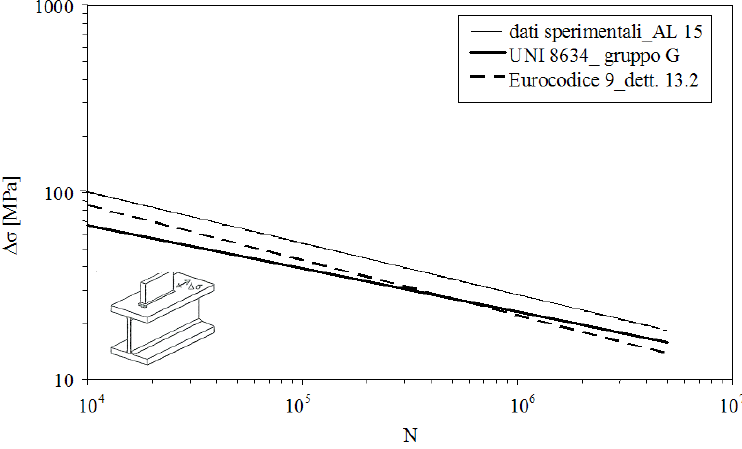
Figura 15: Confronto tra curva di resistenza a fatica per attacchi longitudinali su